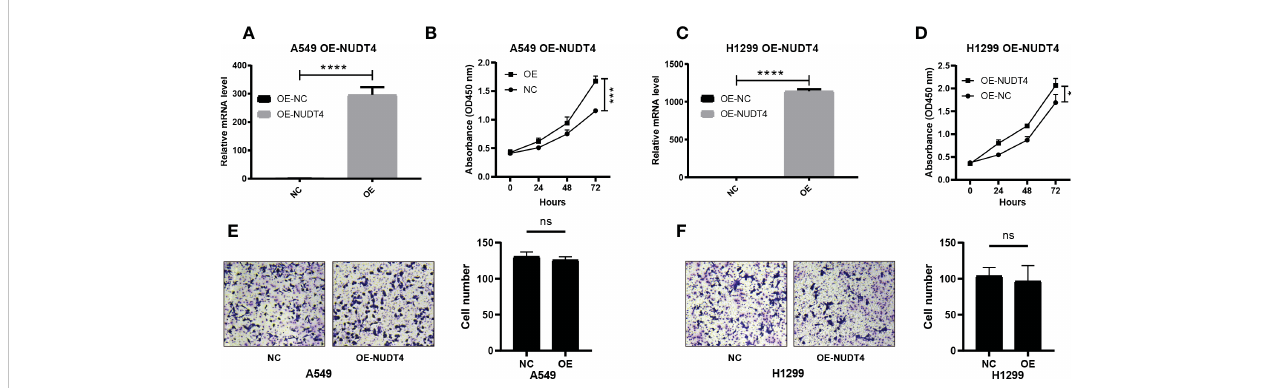
FIGURE 10 Overexpression of NUDT4 in lung adenocarcinoma cell lines. (A) Overexpression level in A549 cell line. (B) CCK8 assay for detecting cell proliferation (n = 3 duplicates). (C) NUDT4 overexpression level in H1299 cell line. (D) CCK8 assay for observing H1299 cell proliferation (n = 3 duplicates). (E) Transwell assay for A549 cell capability of the migration (n = 3 duplicates). (F) Transwell assay for detecting H1299 cell migration (n = 3 duplicates). (* P < 0.05, *** P < 0.001, **** P < 0.0001, ns: Not statistically signi fi